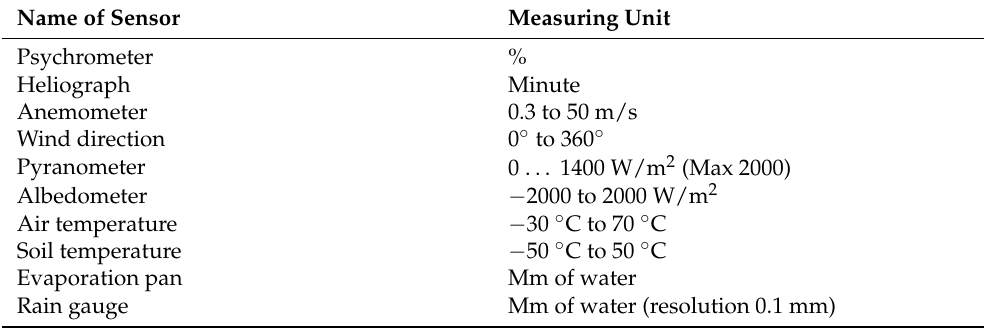
Table 1. Unit and measuring range of the sensors.